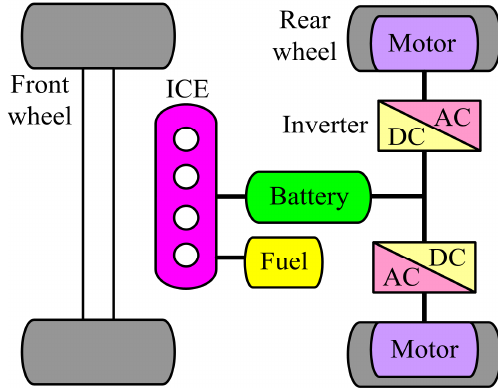
Figure 1. Range-extended electric vehicle (RE-EV) system. ICE: internal combustion engine; DC: direct current; and AC: alternating